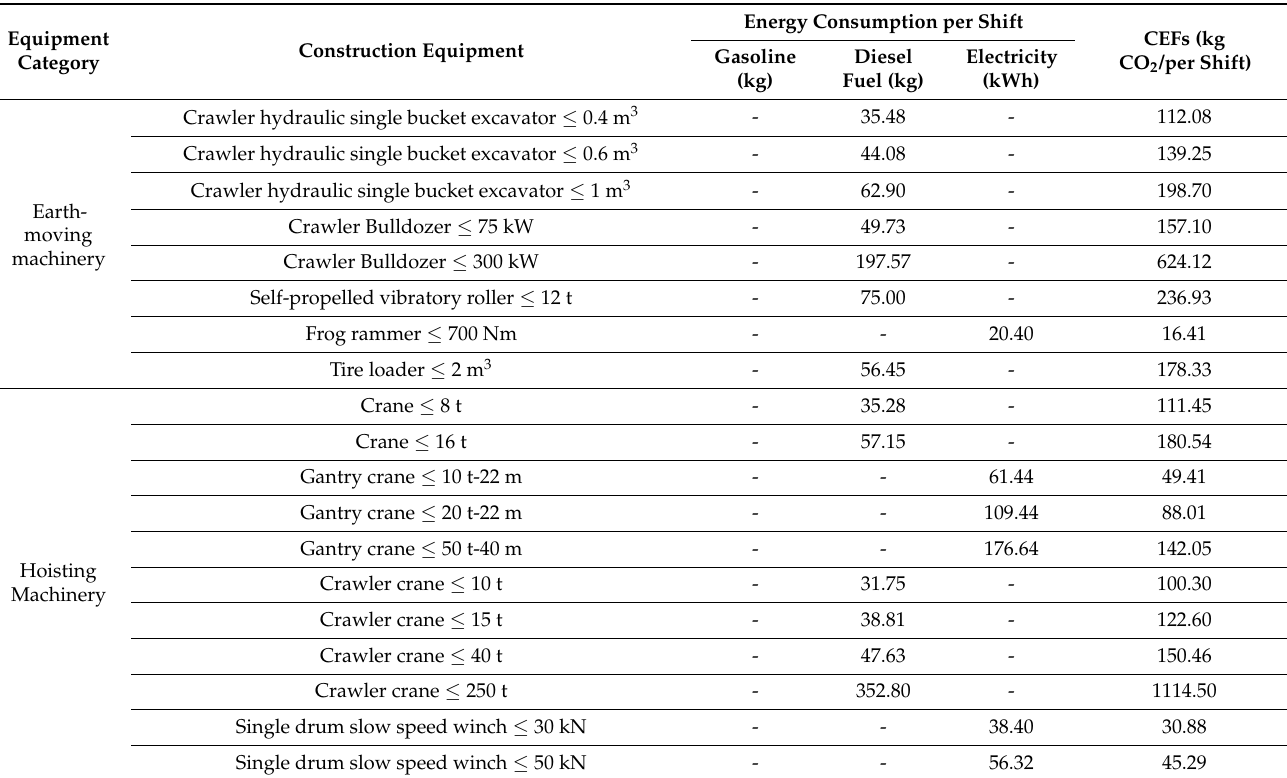
Table 7. Critical construction equipment